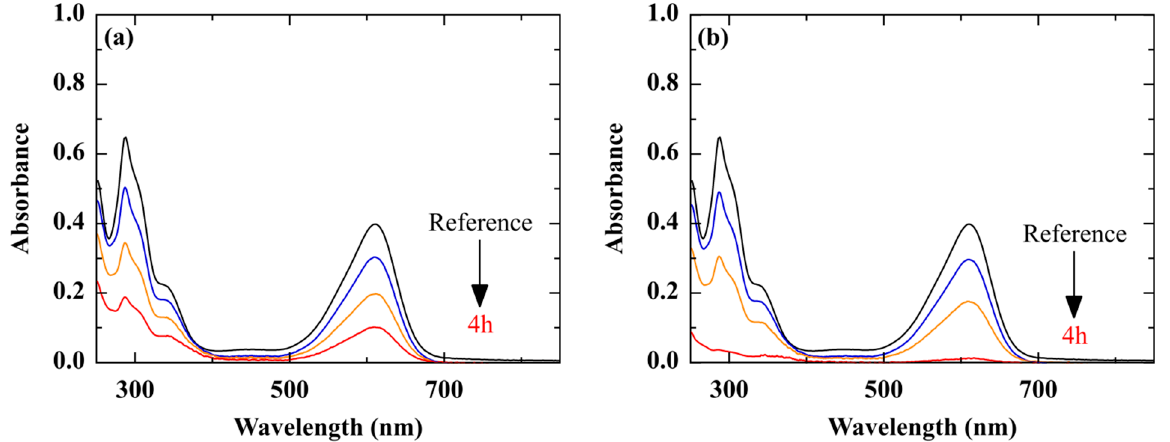
Figure 14. Absorbance spectrum of a CI solution under solar irradiation over time in the presence of pure ZnO thin film ( a ) and ZnO/Ag(10% NPs) thin film ( b ).